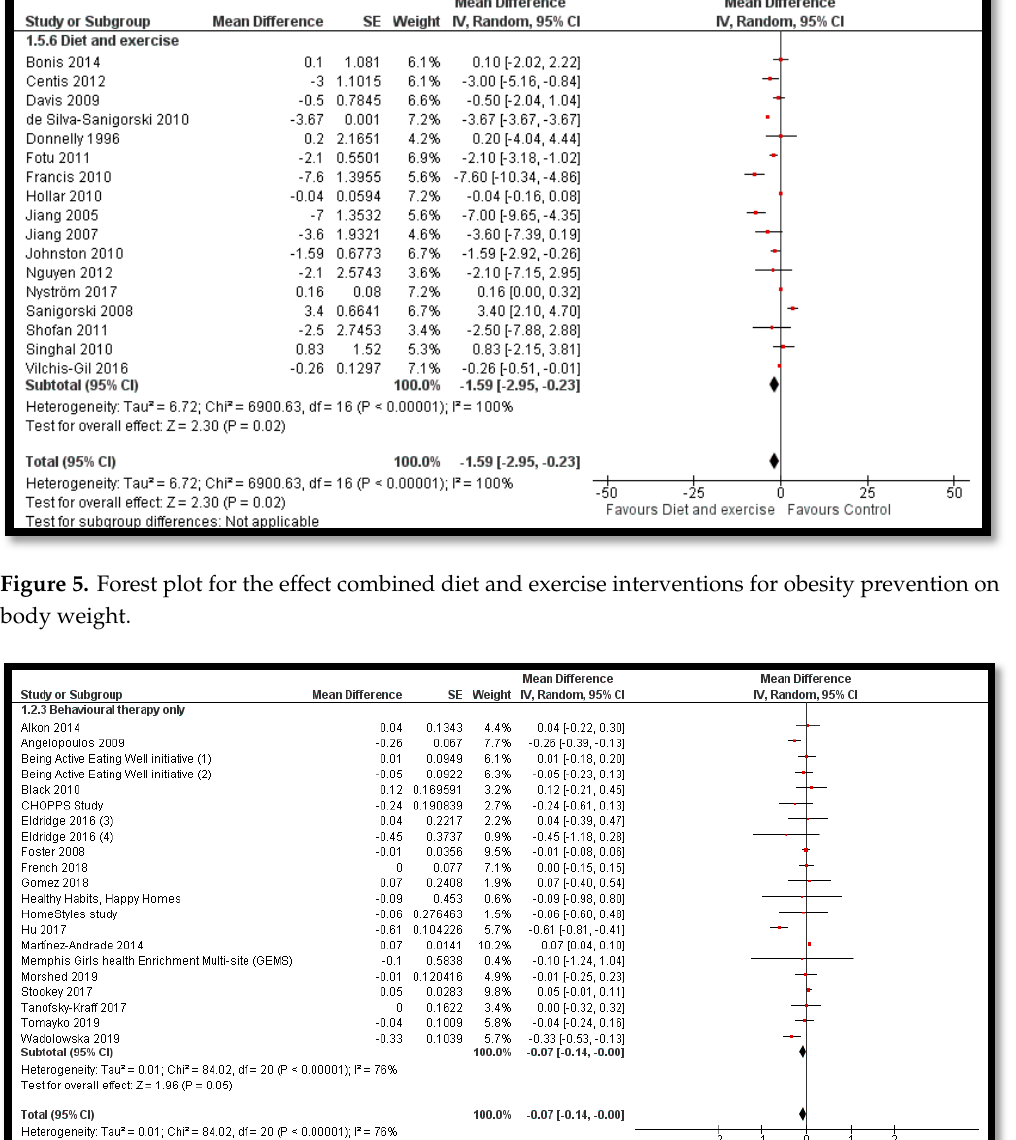
Figure 4. Forest plot for the effect of combined diet and exercise interventions for obesity prevention on body mass index (BMI) z -score .